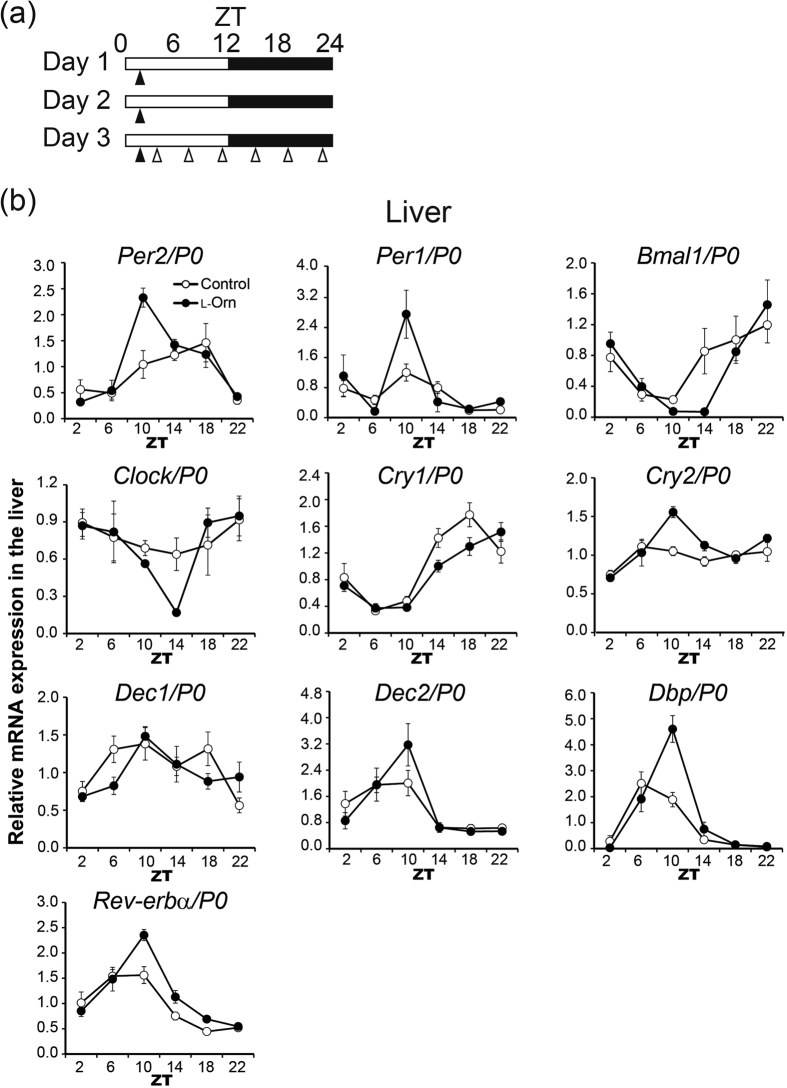
Rhythm of clock gene mRNA expression in the liver detected by time series RT-PCR.(a) Experimental schedule. Open and filled bars indicate light and dark periods, respectively. At ZT 1, l-ornithine (1,000 mg/kg) or vehicle was administered to mice for three consecutive days by oral injection (filled arrowheads). Mice were killed at 4-h intervals throughout the day (open arrowheads). (b) mRNA levels of clock genes in the liver determined by RT-PCR plotted against ZT. All values are expressed as means ± SEM (n = 5–9 mice per group).